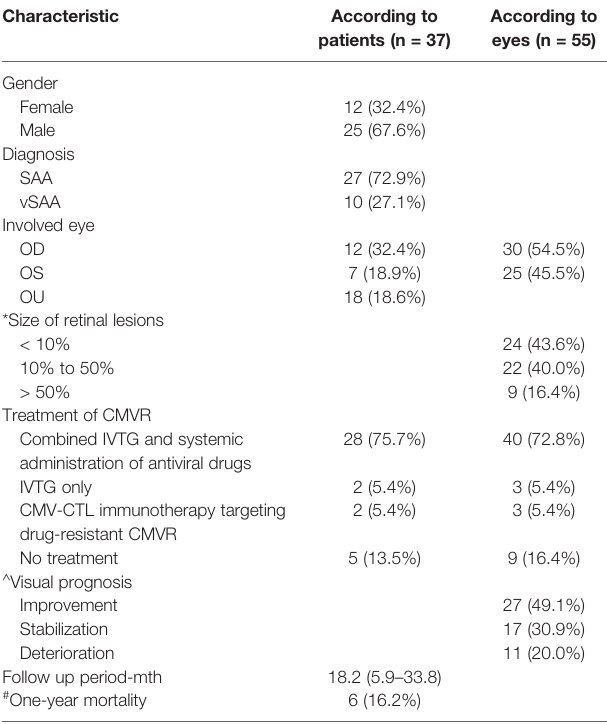
TABLE 2 | Ocular manifestations and clinical outcomes of 37 patients with CMVR. Characteristic According to patients (n =